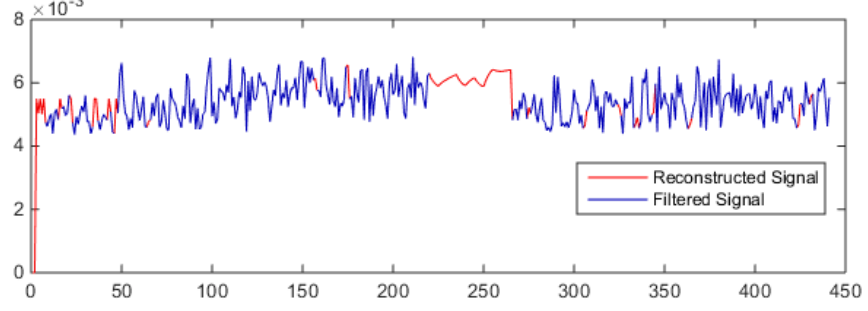
Figure 14. Reconstructed signal.